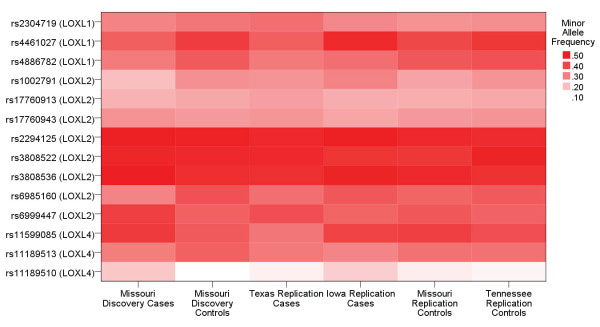
Minor allele frequency comparison between populations. The minor allele frequencies of the SNPs successfully genotyped in the replication phase are represented. The minor allele frequency did not differ significantly between the six populations as assessed by chi squared analysis.